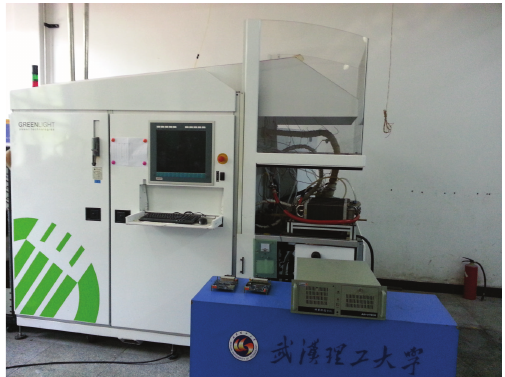
Figure 2: Real hardware-in-the-loop test system.